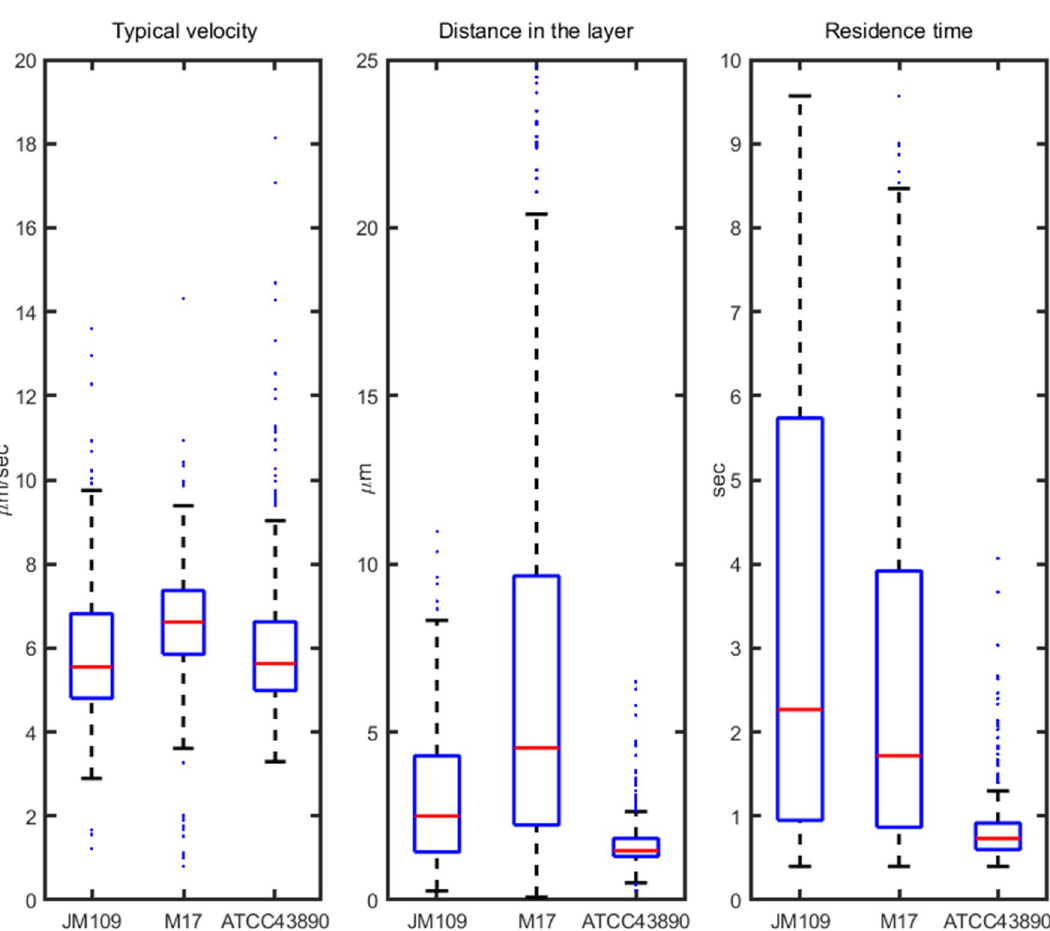
Figure 3. Boxplot with standard whiskers (1.5 IQR) of main characteristics of E. coli strains’ movement: typical bacterium velocity (left), typical distance covered by bacteria within the layer (middle), typical residence time spent in the layer (right). Red lines—median values for characteristics. All distributions consist of ~ 200